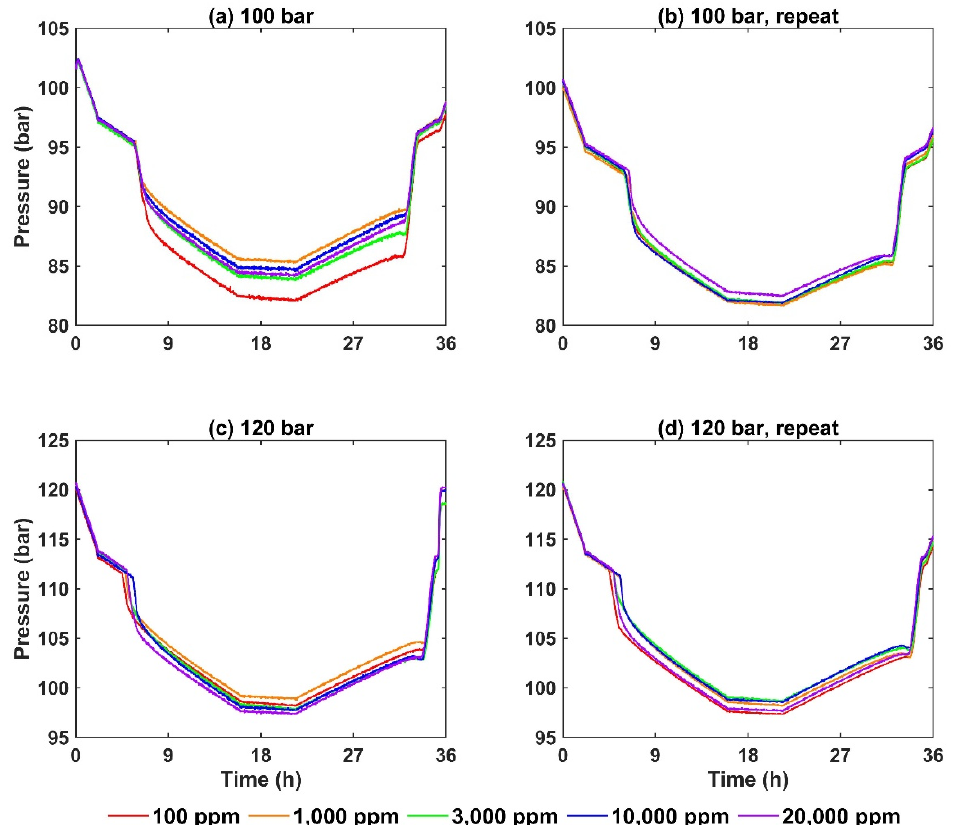
Figure 2. Pressure profiles during the constant ramping temperature scheme in the presence of L-histidine. Starting temperature 25 °C and final temperature 1 °C. Temperature ramping rate 1 °C/h between 15 °C and 1 °C. ( a ) Furthermore, ( b ) show the starting pressure 100 bar (fresh run) and trial 2 (fresh) and ( c , d ) the starting pressure 120 bar for trial 1 and trial 2 (fresh), respectively. ( a ) the starting pressure was 102 bar in place of 100 bar.